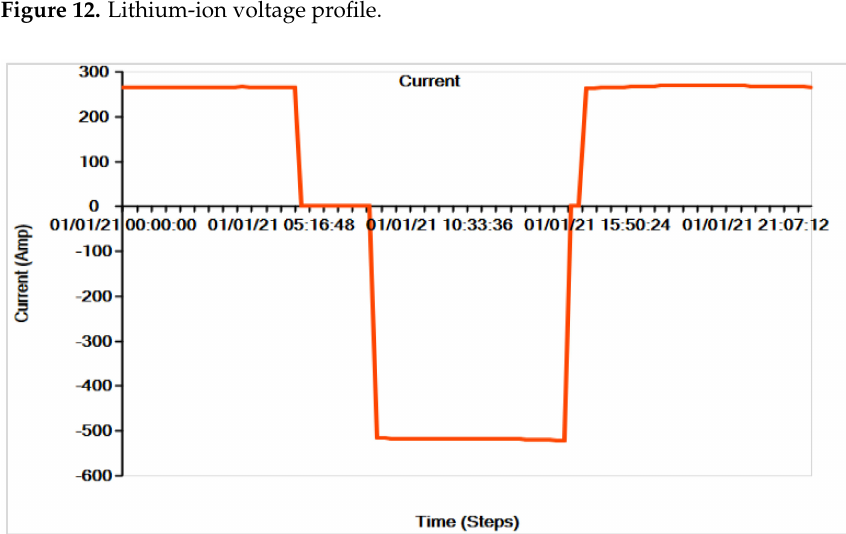
Figure 13. Lead–acid current